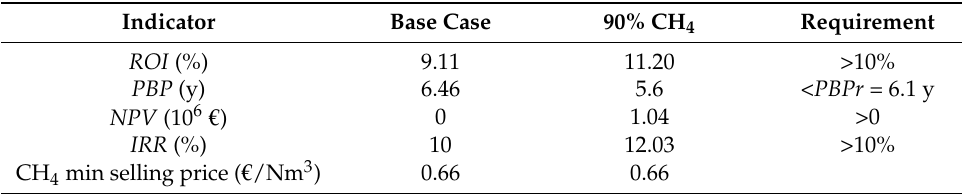
Table 6. Economics metrics for the 90% CH 4 content scenario at a price of 0.66 € /Nm 3 .